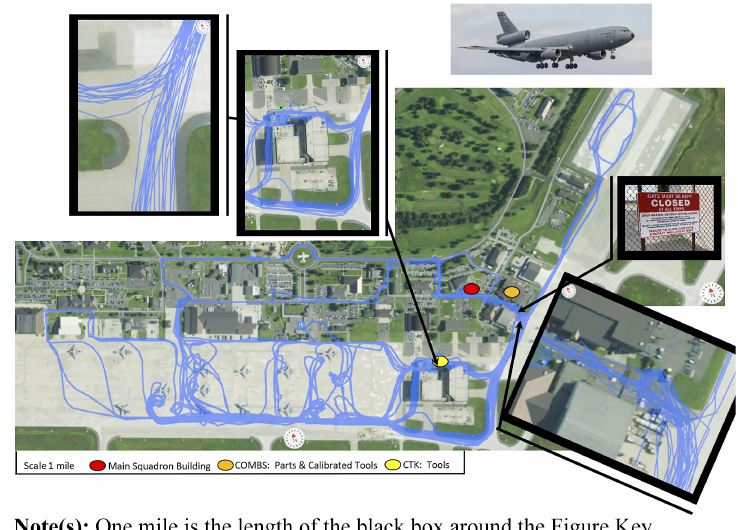
Figure 1. Spaghetti diagram: GPS tracking of ride- along with KC-10 expediter at JB MDL, New Jersey (NJ)